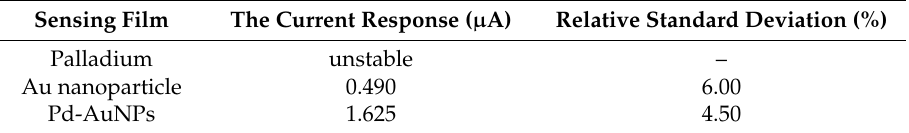
Figure 5. The linear scanning curves of the Pd ‐ AuNPs composite sensing film modified chip in the base solution and the nitrate solution with a concentration of 0.5 mg ∙ L − 1 . Table 1. The responses to nitrate of the chips modified with different sensing film.